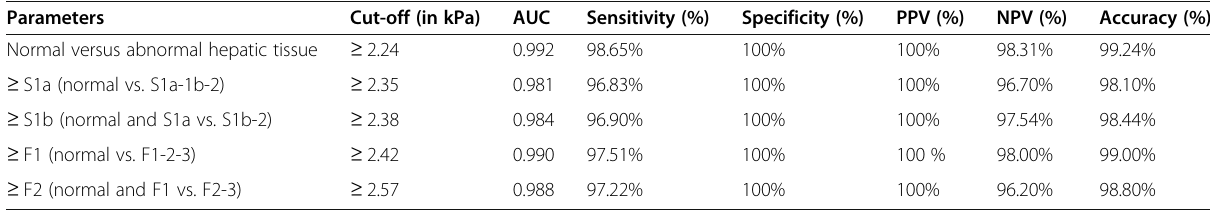
Table 5 The accuracy of liver stiffness estimated by MRE in discrimination between normal and abnormal hepatic tissue in the LLD candidates of the present study ( n = 37)